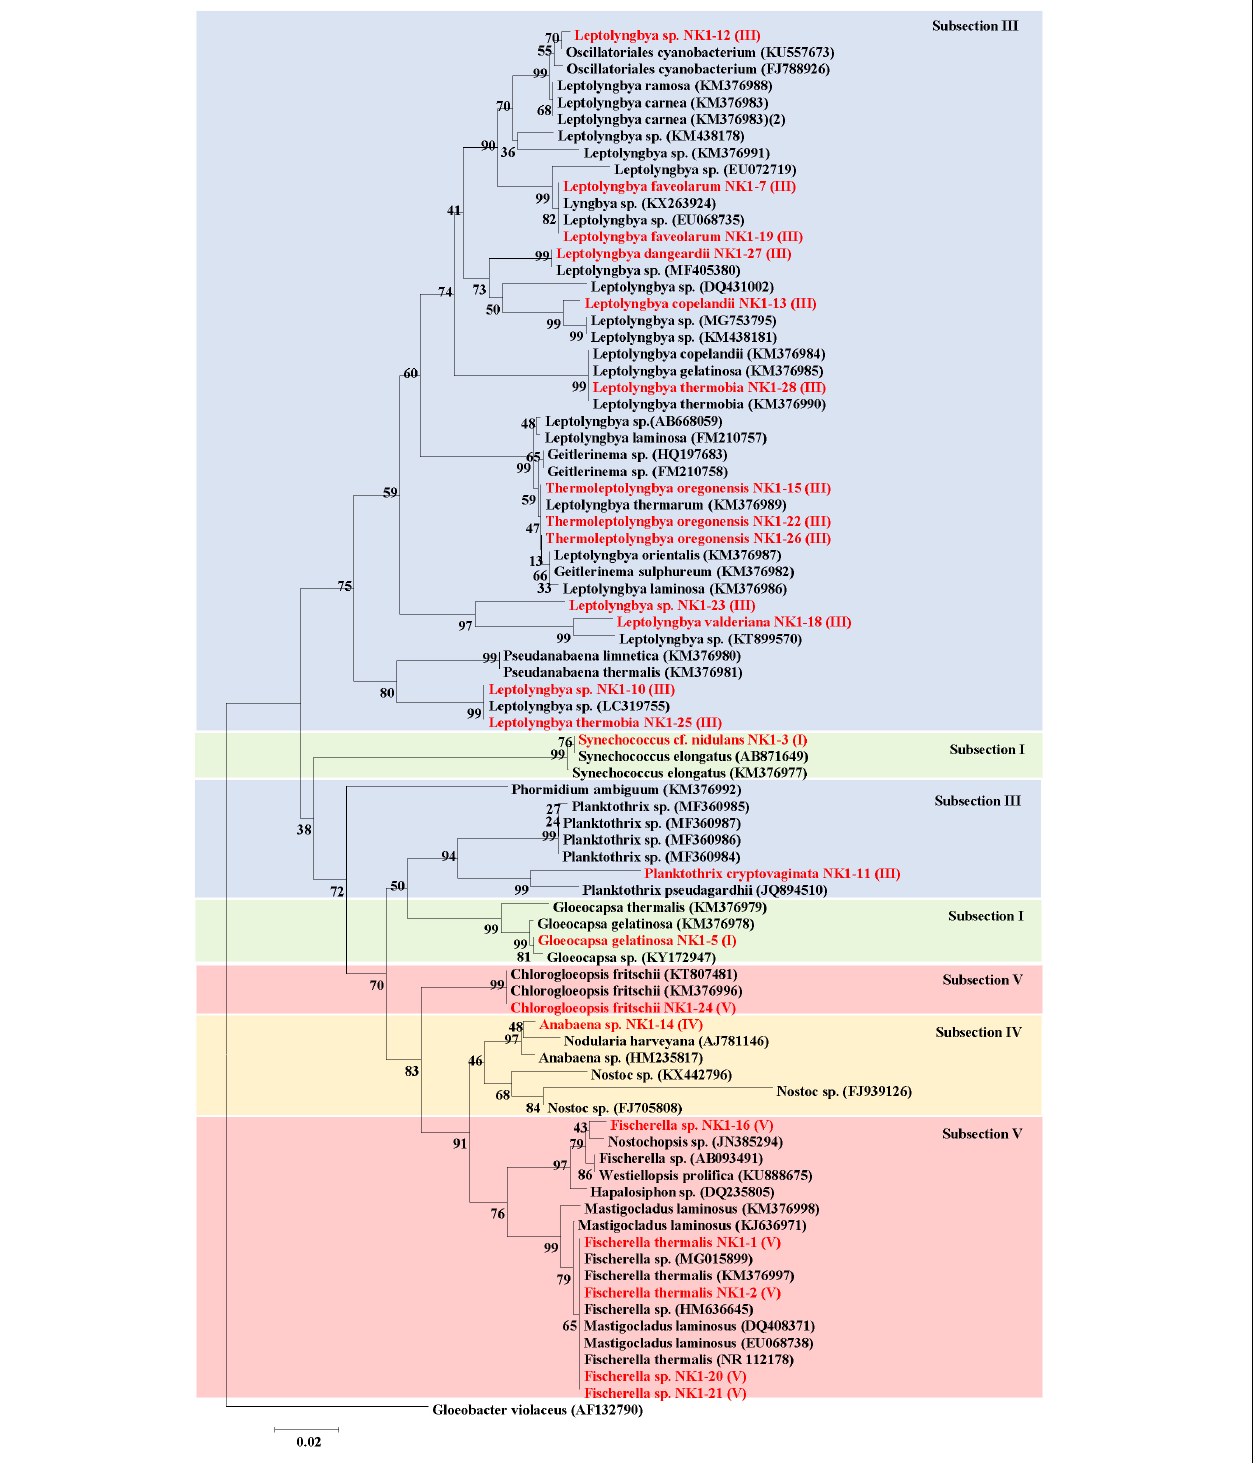
FIGURE 8 | Phylogenetic relationships (Neighbor-Joining) between the isolated cyanobacteria species of hot springs of Yunnan Province, China and other closest relative hot spring cyanobacteria based on 16S rRNA gene sequences. Isolated cyanobacteria were indicated in red color. The number near the node represents the bootstrap value. Subsection was mentioned in brackets. Gloeobacter violaceus PCC 7421 (AF132790) was used as an out-group.